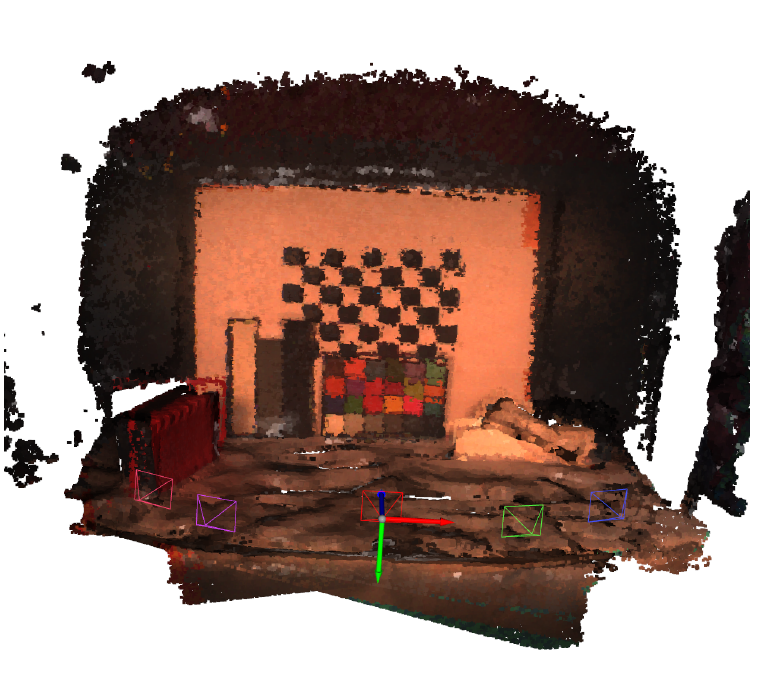
Figure 8. The fully registered point cloud with pseudo RGB coloring and the visualizations of camera capture